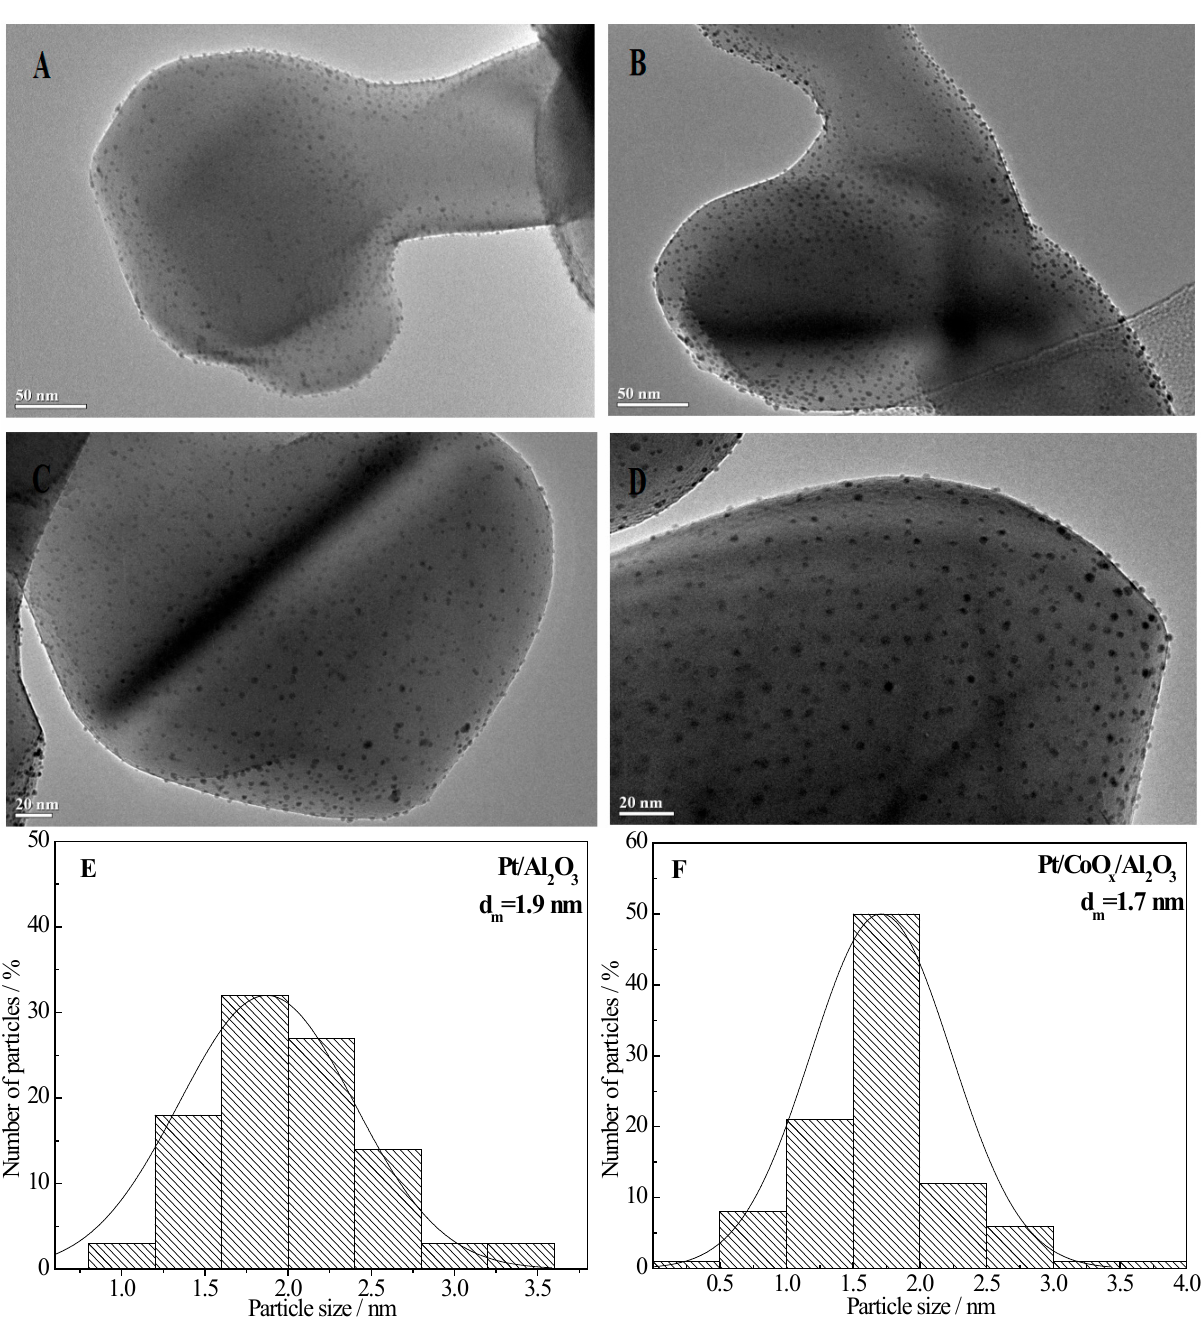
Figure 10. TEM images of the spent Pt/Al 2 O 3 ( A , B ) and Pt/CoO x /Al 2 O 3 ( C , D ) catalysts. Size distributions of Pt particles of spent Pt/Al 2 O 3 ( E ) and Pt/CoO x /Al 2 O 3 ( F